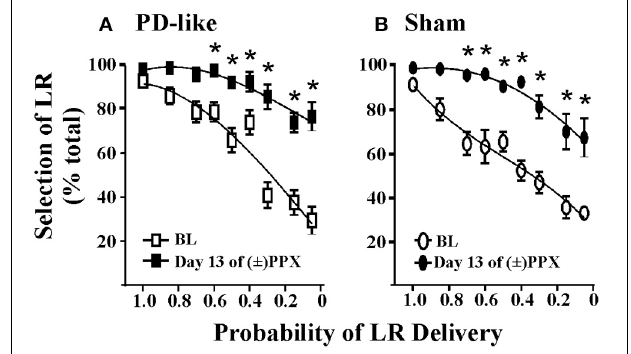
FIGURE 2 | Effects of pramipexole on risk/reward decision-making using a probability discounting task. Chronic ( ± )PPX decreases discounting in PD-like (A) and sham control (B) rats. Briefly describing the task, PD-like ( n = 11) and sham control ( n = 10) rats were trained in the probability discounting task using ICSS. Probabilities associated with delivery of the large reinforcer (LR) were presented in a pseudo-randomized order. Once stable behavior was observed, rats were treated chronically with twice daily injections of 2mg/kg ( ± )PPX for 13 days. Data shown were collected from the time point in which we observed the peak effect on the final day of treatment (i.e., 6h post injection) and are compared with the pretreatment baseline (BL). Shown is the percent selection of the LR (i.e., free-choice ratio) vs. the probability that the LR was delivered. A Two-Way rmANOVA with post hoc Newman-Keuls revealed significant increases in % selection of the uncertain, LR following chronic PPX treatment ( ∗ p < 0 . 05) for both PD-like and sham rat groups. Although the group averages indicate a PPX-induced increase in suboptimal risk/reward decision-making, two rats in each group showed less than a 20% increase from baseline at the lowest probability tested; therefore, some rats appeared to be insensitive to the ability of the drug to modify probability discounting. Figure modified from Rokosik and Napier (2012) and reprinted with permission from the